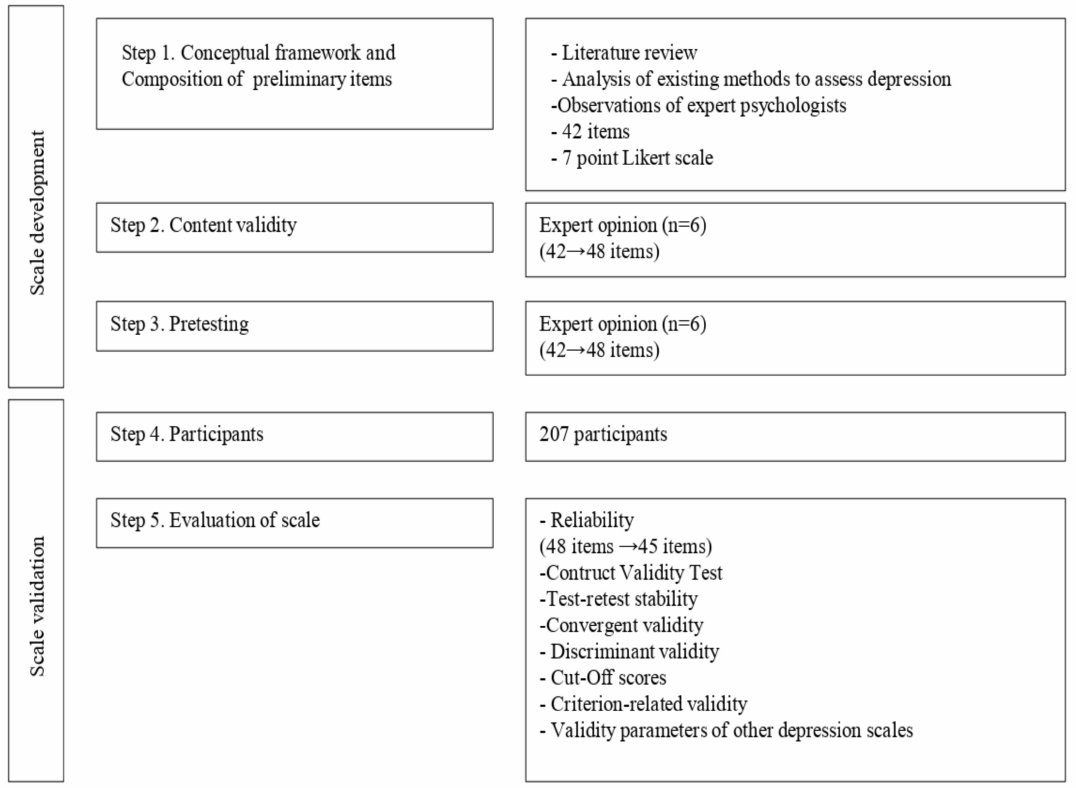
Figure 1. Steps of scale development and